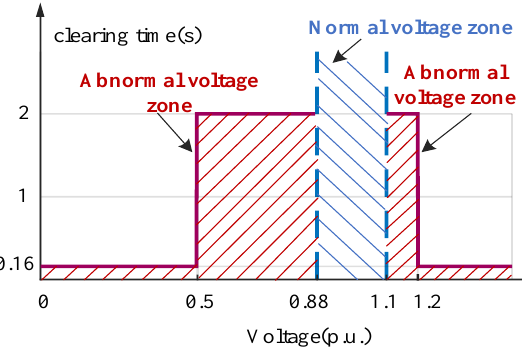
Figure 8. Clearing time of inverters under different voltage faults.